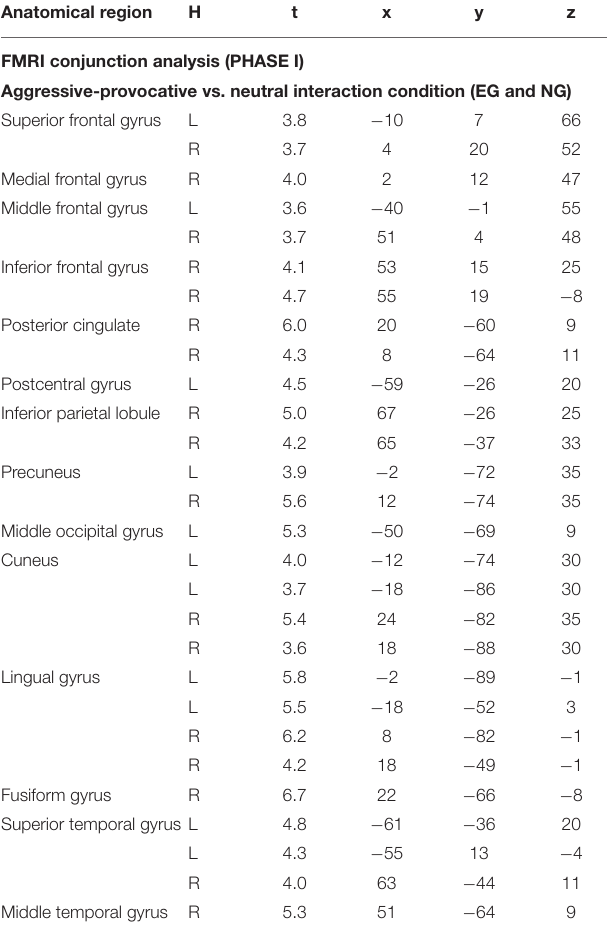
TABLE 4 | Anatomical regions, peak activation t-values, and Talairach-coordinates for conjunction {null} analysis “EG and NG” including contrast images for aggressive-provocative (a1) vs. neutral (n1) stimulus condition for the initial PHASE I; H, hemisphere; L, left; R, right; statistics: p < 0.05, FDR-corrected, minimum voxel cluster size k = 5 voxels; EG = participant group with enhanced violence-related socialization, NG = participant group with normal violence-related